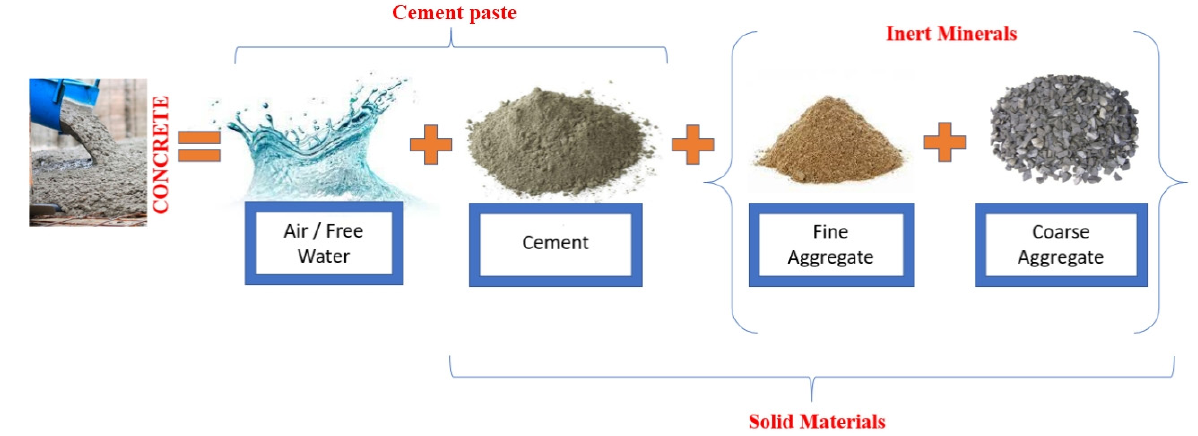
Figure 5. Basics materials of concrete composition.